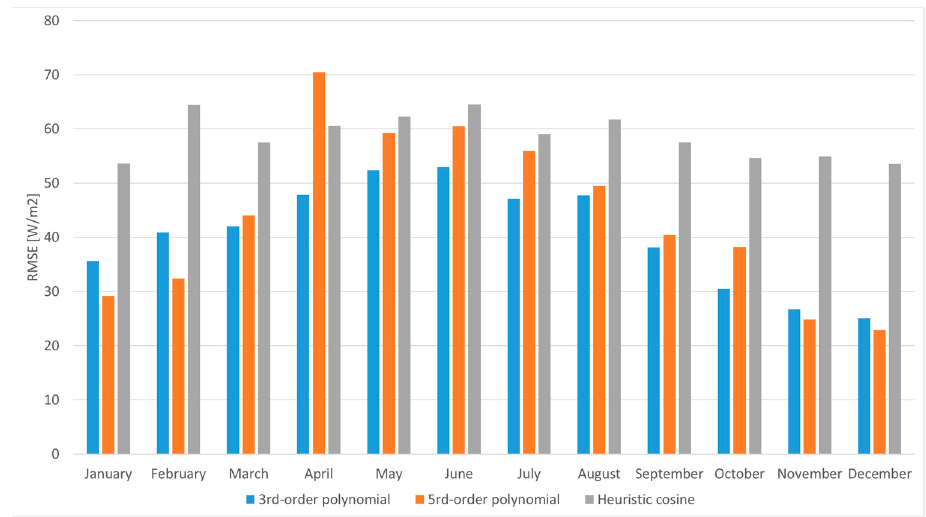
Figure 13. Root-mean-squared error value for resultant bivariate functions, depending on the measurement month.